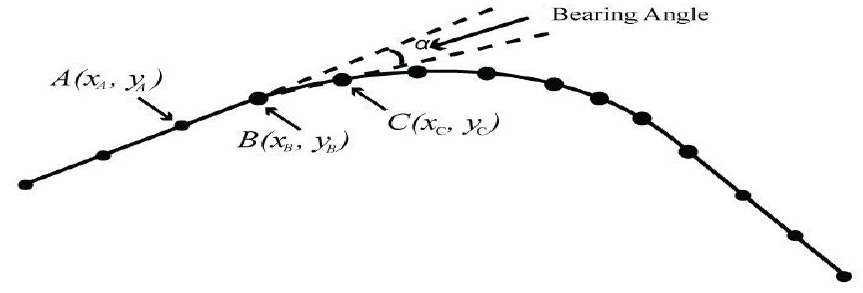
Figure 4. Bearing angle